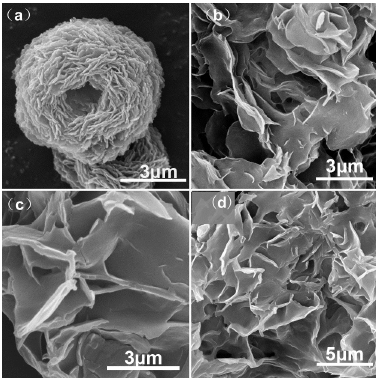
Figure 2. Scanning electron microscopy (SEM) images of the polymerization products of C 18 H 37 SiH 3